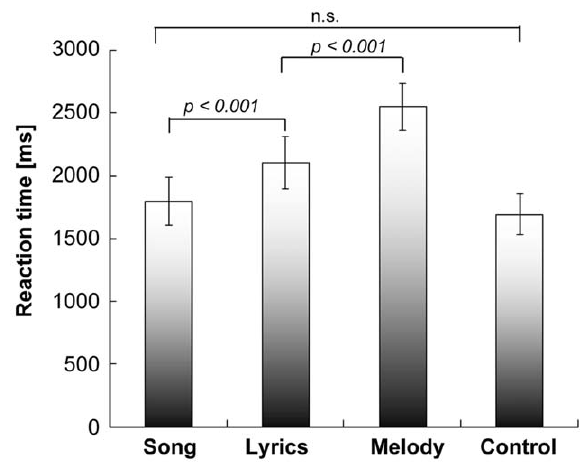
Figure 3. Mean reaction times for the four different conditions. Error bars indicate the standard error ( P , 0.001, Bonferroni corrected).